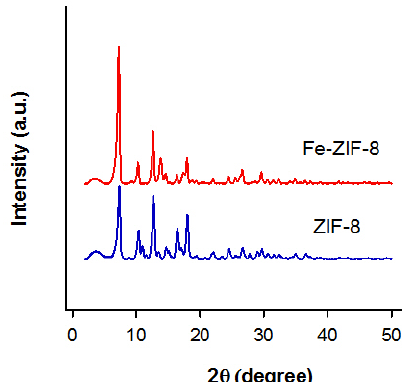
Fig. 1. XRD pattern of the ZIF-8 and Fe-ZIF-8